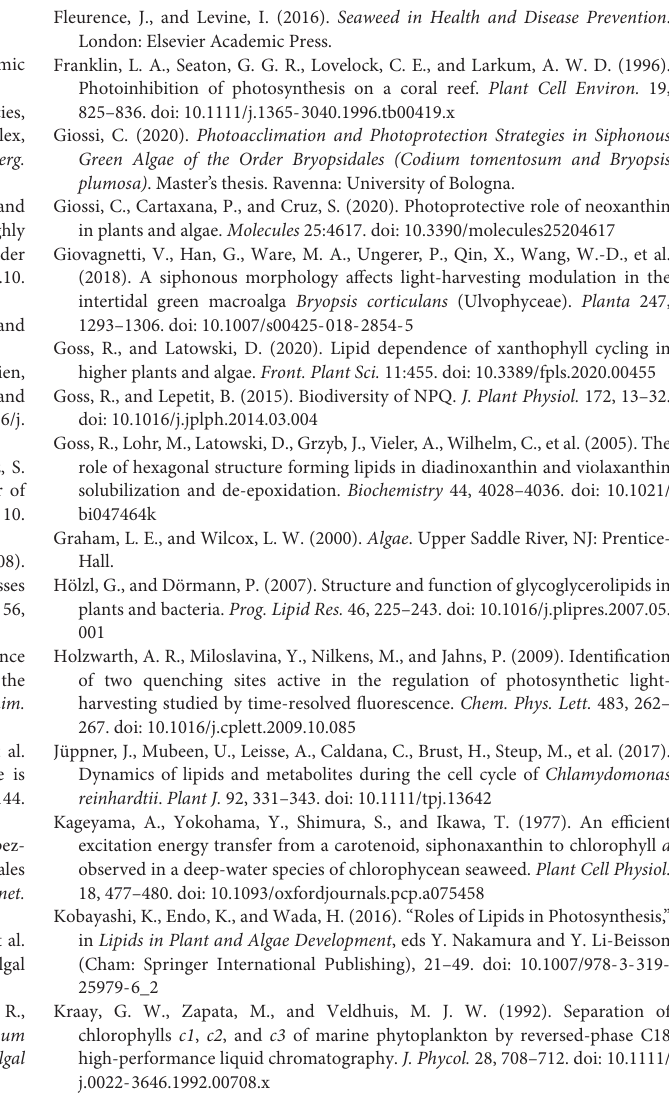
Supplementary Figure 1 | Content of c -Neo, Siph, Siph-do, Chl b , ε - and α -Car (pigment:Chl a ratios, mean ± SD; n = 5) of low light (LL) and high light (HL) grown macroalgae during 7 days of light acclimation. (A) Codium tomentosum; (B) Bryopsis plumosa. Asterisks indicate significant differences between LL